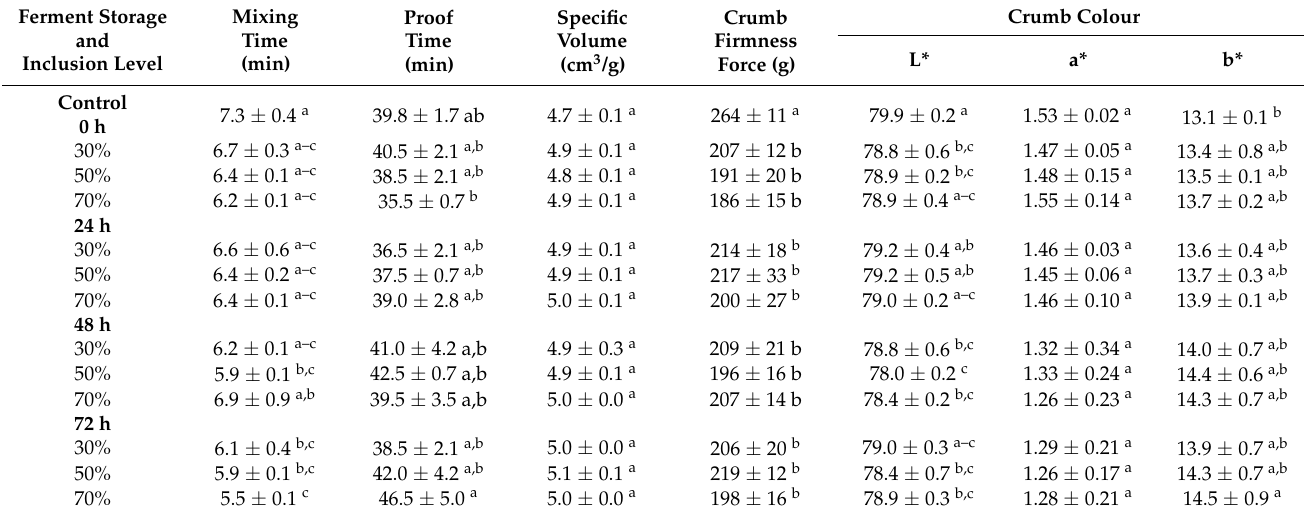
Table 7. Processing parameters, bread specific volume, crumb firmness and colour of the control and breads containing ferment stored for varying periods of time 1